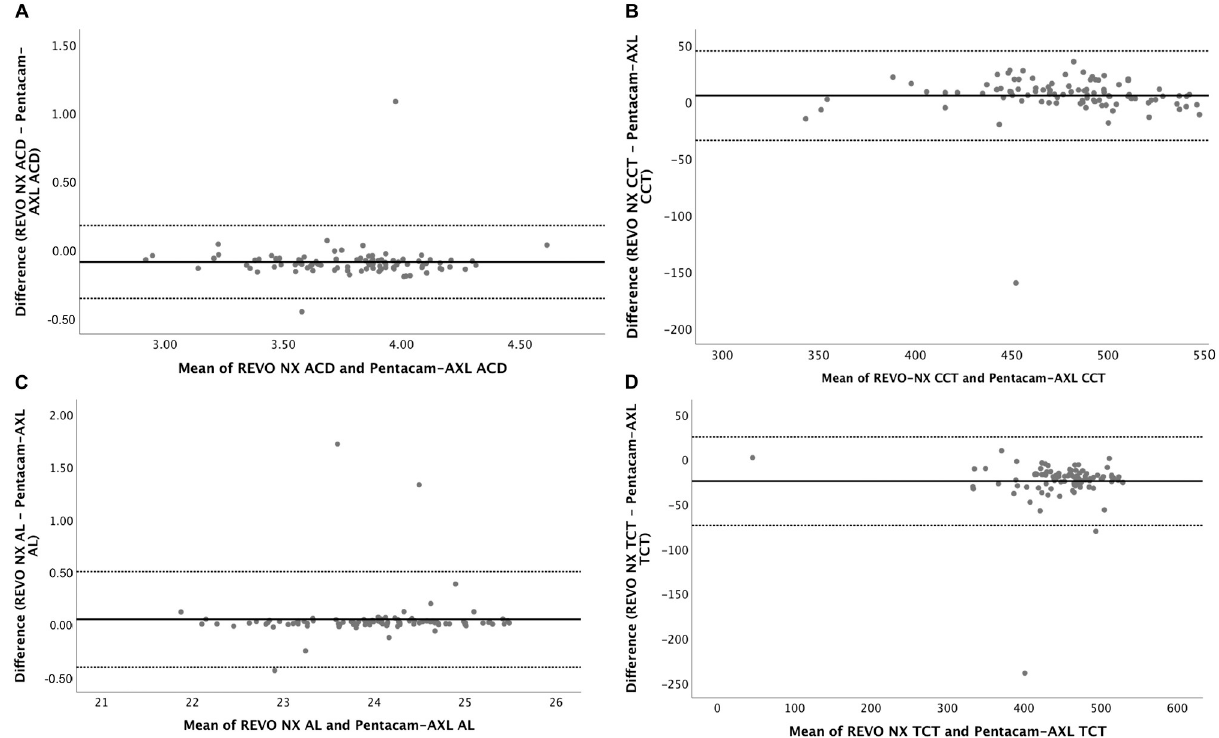
Fig 1. Bland-Altman plots for ACD (1A), CCT (1B), AL (1C), and TCT (1D) for REVO-NX and Pentacam-AXL in Group A eyes. ACD, anterior chamber depth; CCT, central corneal thickness; AL, axial length; TCT, thinnest corneal